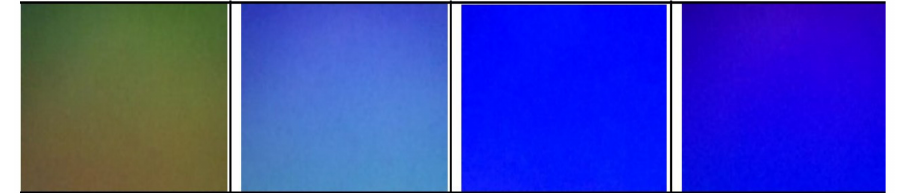
Figure 12. Images captured when the timestamps have an error of half a